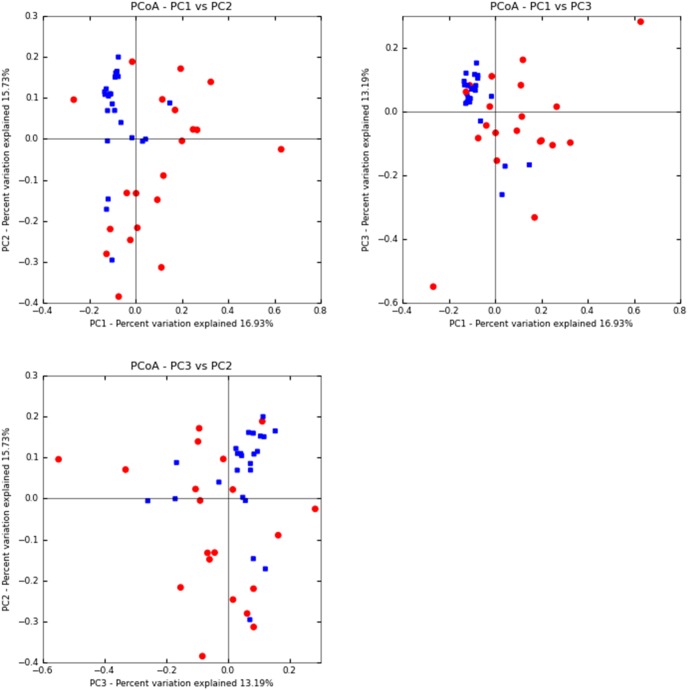
Principal component analysis of Uni Frac distance metric.The plot was generated using sequences from individual pigs at week 2 (red circles) and 8 (blue squares) post-weaning fed diets differing in diet complexity and with or without antibiotic inclusion from week 0–6 post-weaning. All pigs received a common grower diet thereafter.